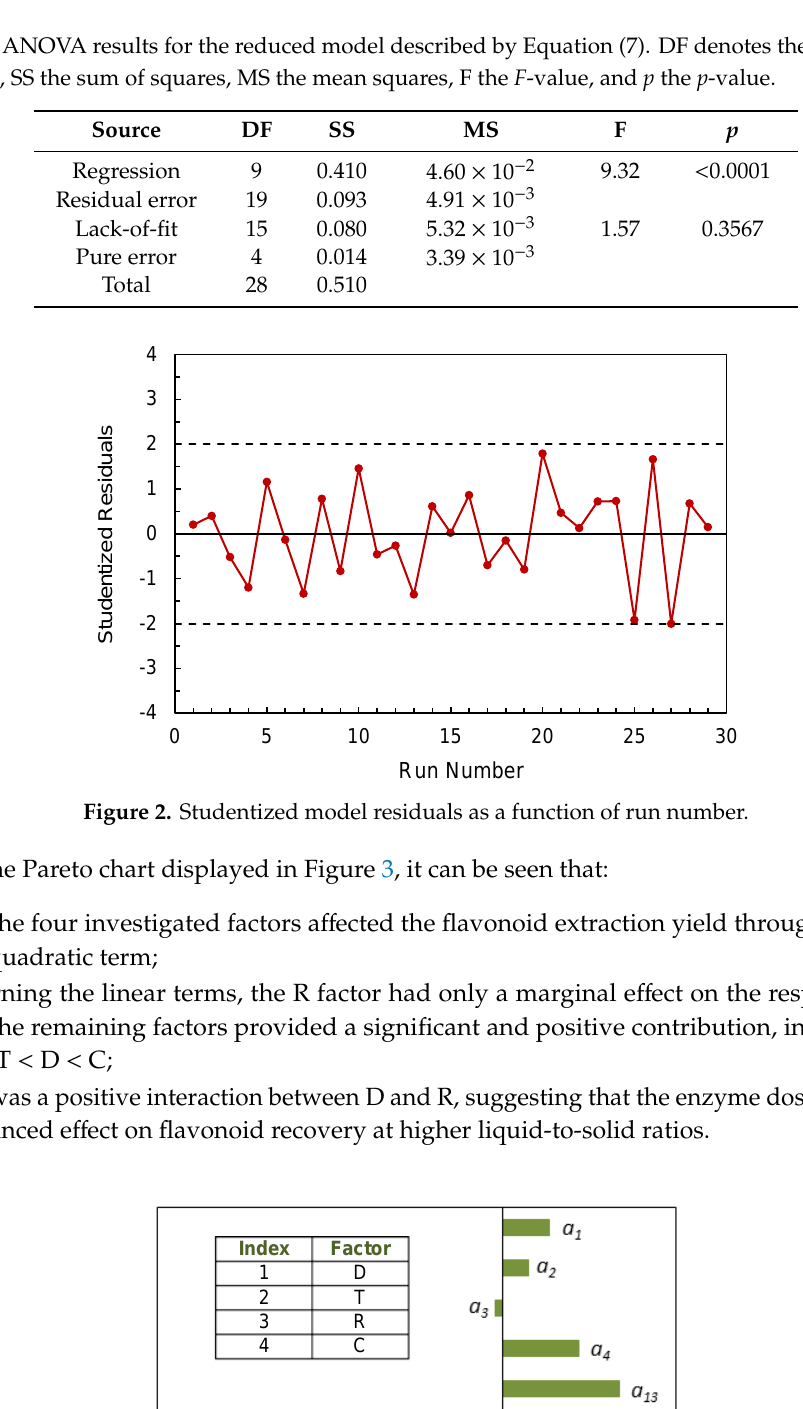
Figure 3. Pareto chart for the model coefficients.